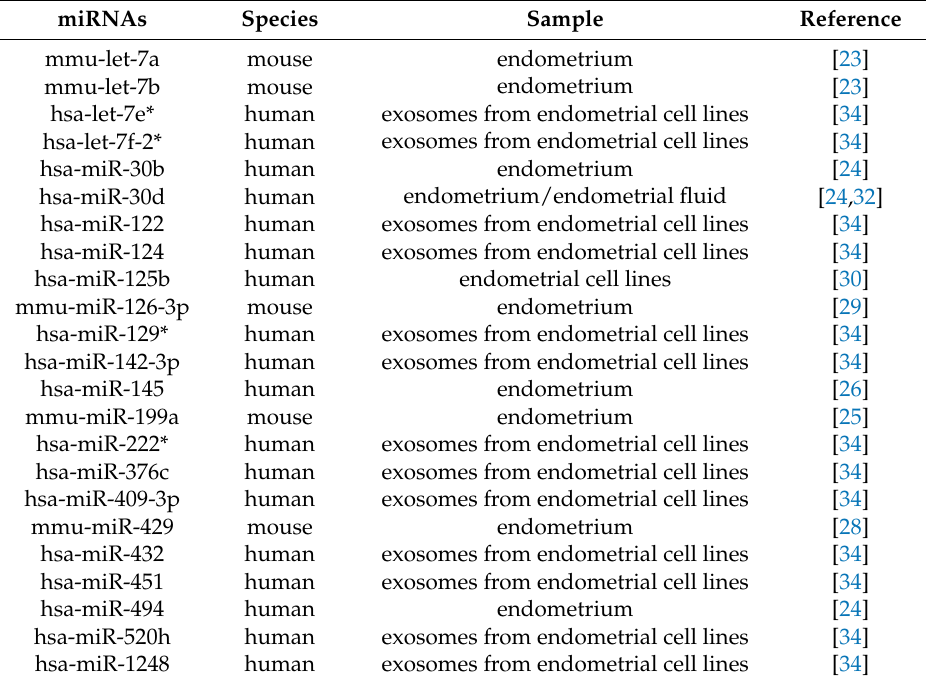
Table 1. miRNAs involved in embryo